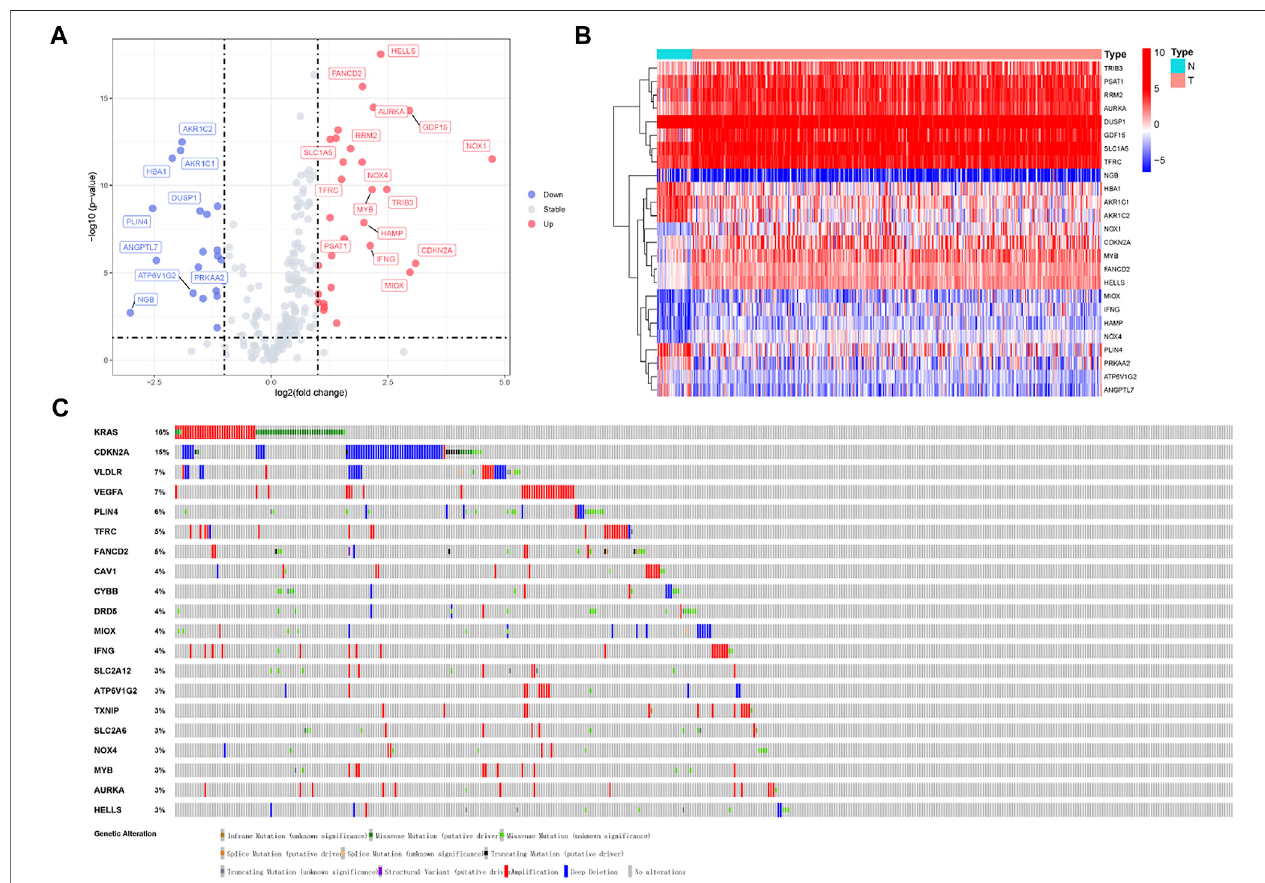
FIGURE 2 | Volcano plot and heatmap of ferroptosis-related genes of stomach adenocarcinoma samples in TCGA-STAD Project. (A) Volcano plot of 259 ferroptosis-related genes in TCGA-STAD Project. (B) Heatmap of 25 differentially expressed ferroptosis-related genes (log2|fold change| > 1.5). (C) Mutations in differentially expressed ferroptosis-related genes. 20 genes have a mutation rate ≥